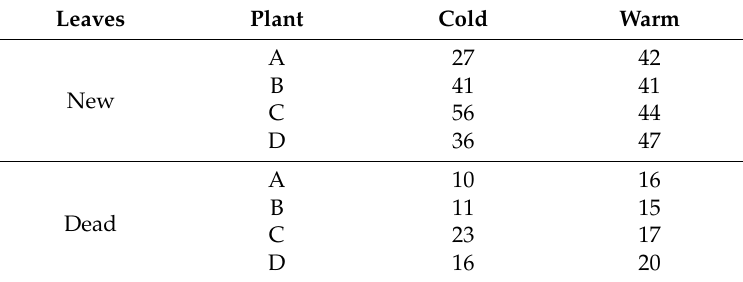
Table 2. Total number of new and dead leaves per plant during the entire growth period in each lighting condition. Leaves Plant Cold Warm A New